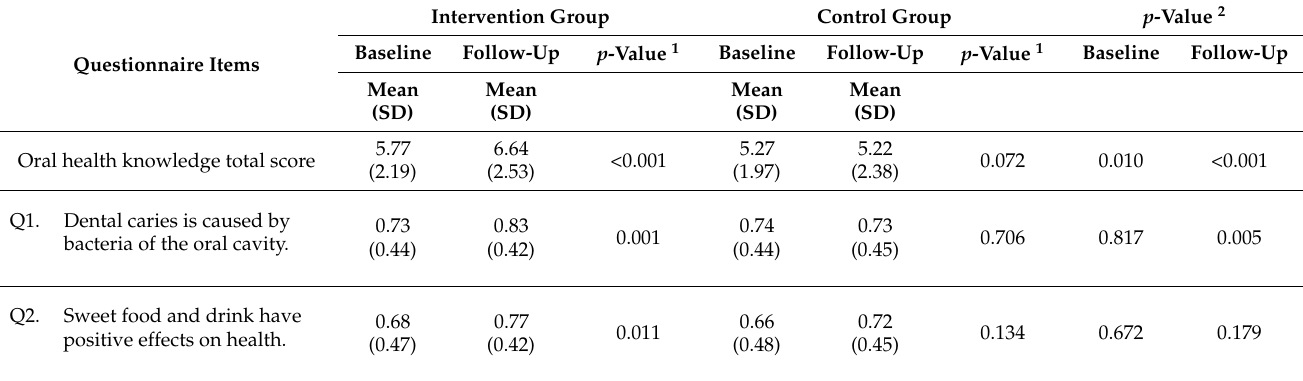
Table 1. Oral health knowledge questions with scores at baseline and 6-month